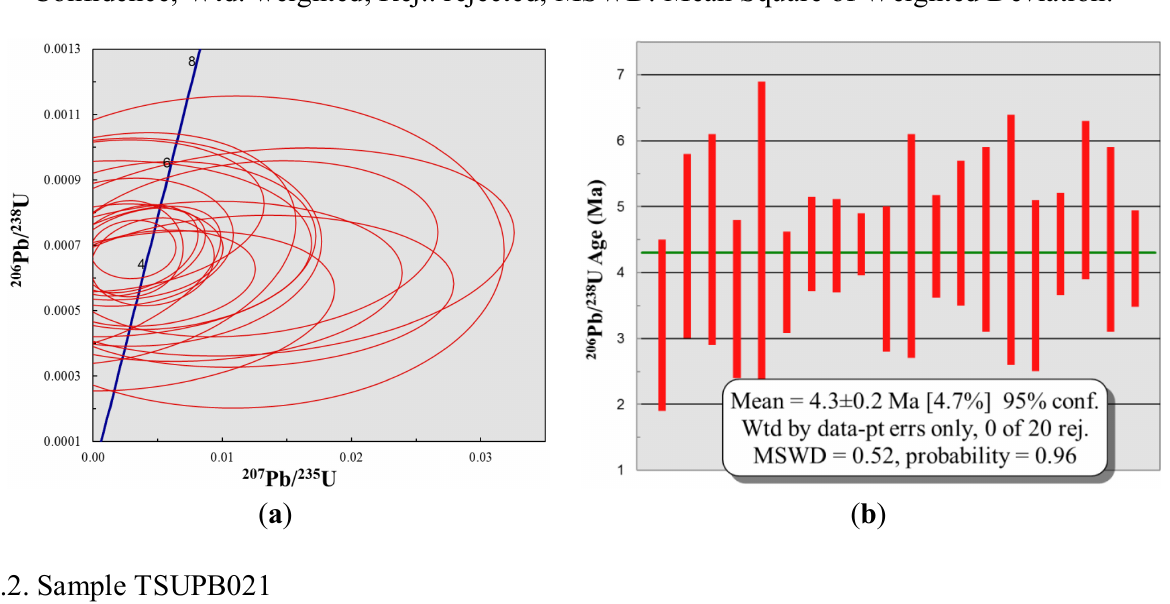
Figure 4. U–Pb data for chemically abraded Penglai zircon reference material: ( a ) Concordia plot; and ( b ) weighted mean 206 Pb/ 238 U age. Error ellipses and box heights are 2σ. Conf.: Confidence; Wtd: weighted; Rej.: rejected; MSWD: Mean Square of Weighted